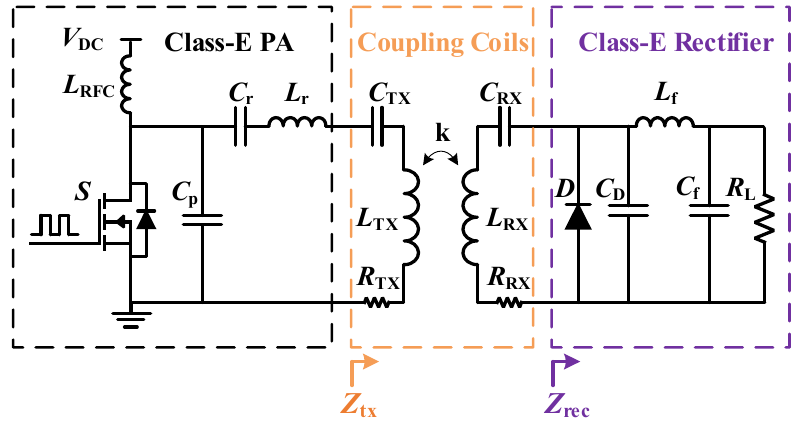
Figure 1. Circuit model of a conventional Class-E2-based WPT